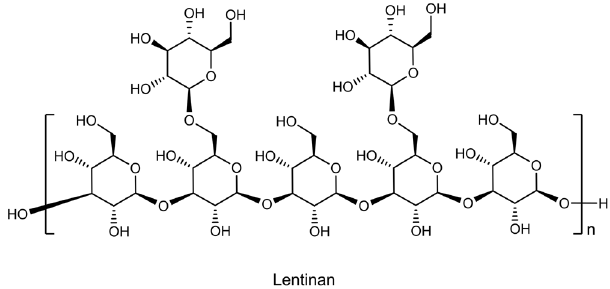
Fig. 1 | Chemical structure of lentinan, a (1 → 3)(1 → 6)- β -glucan with two (1 → 6)- β - glucose branches every fi ve glucose units in the (1 → 3)- β -linked main